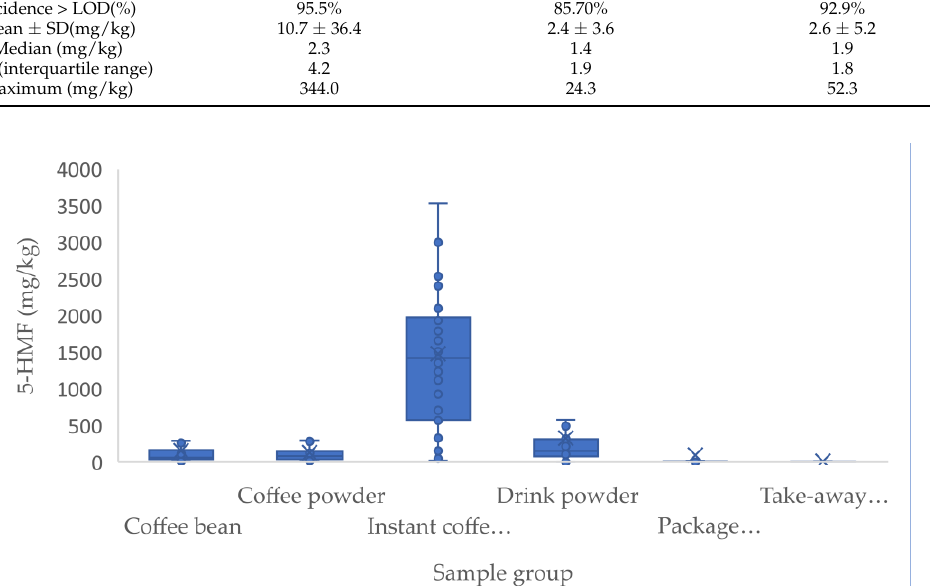
Figure 1. Box plots comparing 5-HMF concentrations in 6 coffee products in 2021. Lower and upper ends of the box represent the lower and upper quartiles (25th and 75th percentiles), the middle line represents the median, and the whiskers represent the minimum and maximum, excluding outliers.